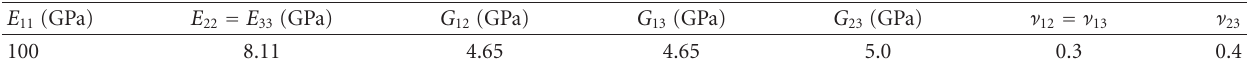
Table 1: Mechanical properties of each ply.